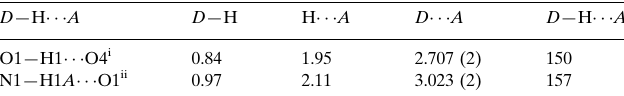
Hydrogen-bond geometry (A˚ , (cid:2)